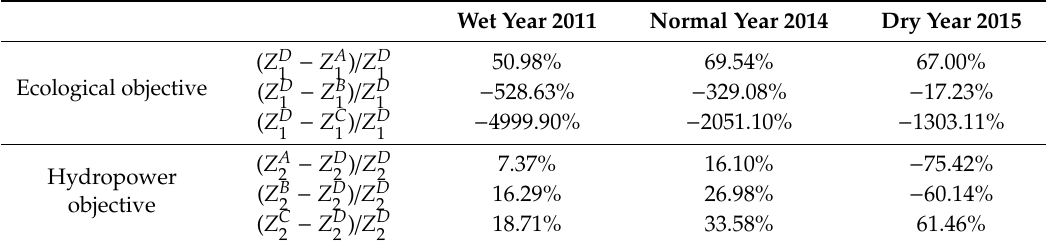
Table 4. Optimization ratio of the objectives compared with the natural flow.